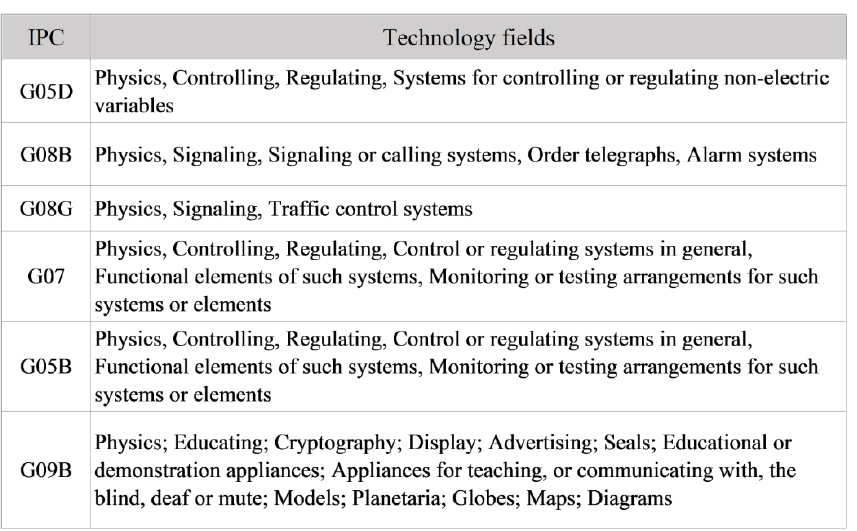
Fig. 7 Definitions of IPC numbers under